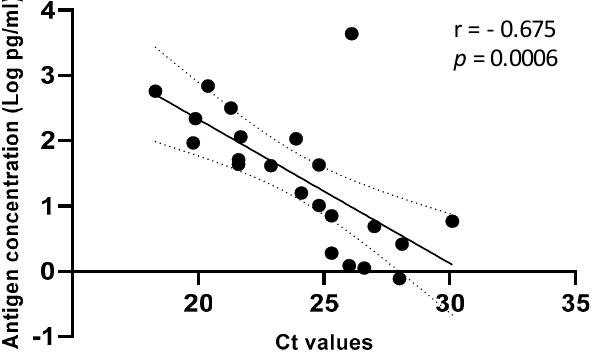
Figure 2. Correlation between Ag concentration (Log pg/mL) and Ct values on fresh saliva samples. Linear regression with 95% of Confidence Interval (dashed line).